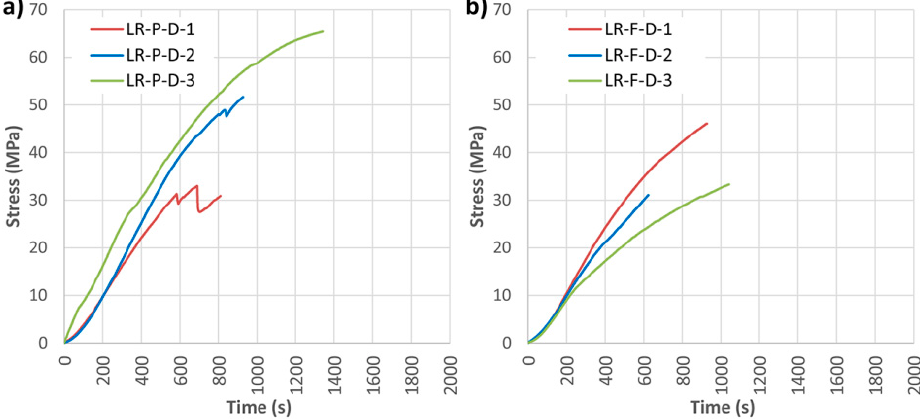
Figure 11. Stress against time for longitudinal reinforced beams (LR): ( a ) LR-P-D; and ( b ) LR-F-D. CFRP supplier: DRIZORO ® . Table 4. Mechanical results obtained from bending tests for LR-P-D and LR-F-D beams. Visual classification, MOR, density, density-corrected MOR, MOE, maximum deflection and type of failure. CFRP supplier: DRIZORO ® .